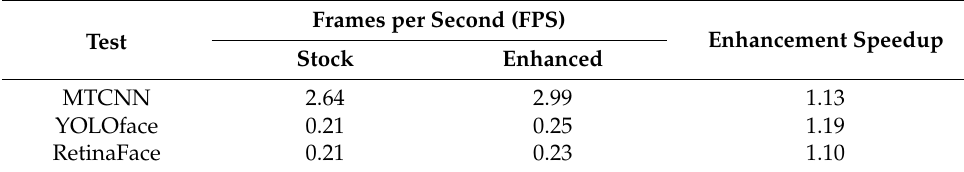
Table 7. Results for Experiment 3 using the enhancements for Pi